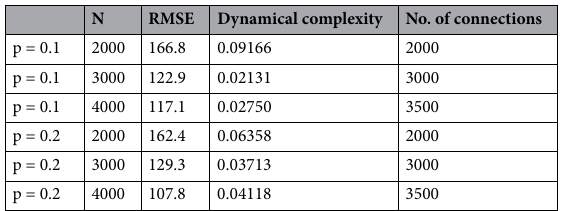
Table 2. Biological plausibility